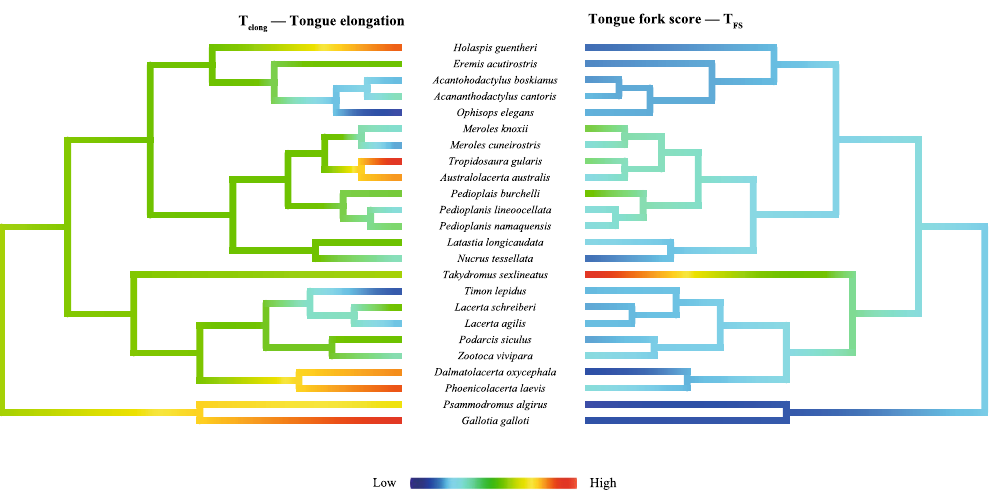
Figure 4. Ancestral character estimation of tongue elongation (T elong ) and forkedness (T FS ) along the branches and nodes of the tree for 24 lacertid lizard species. The illustration succeeds in visualizing the phylogenetic conservative character of both traits (Blomberg’s K > 1). Illustration made in R (function ‘contMap’, package ‘phytools’ 97 ).